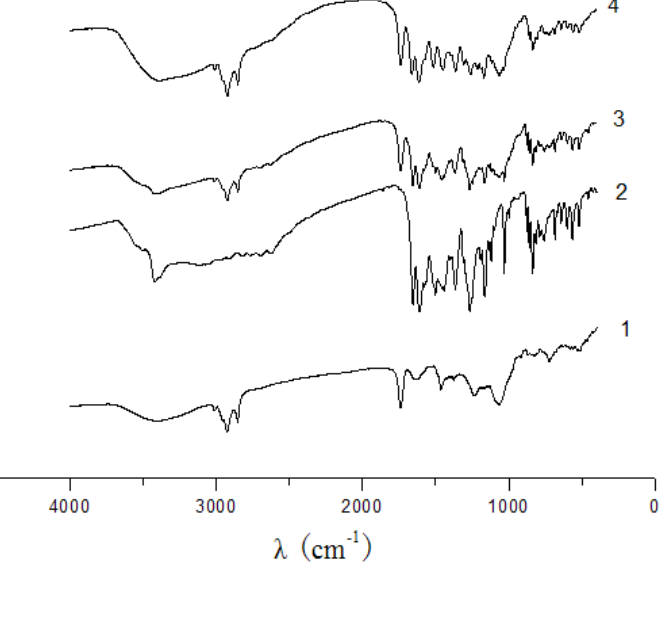
Figure 3. IR spectra of phospholipid (1), luteolin (2), physical mixture of luteolin and phospholipid (3), luteolin-phospholipid complex